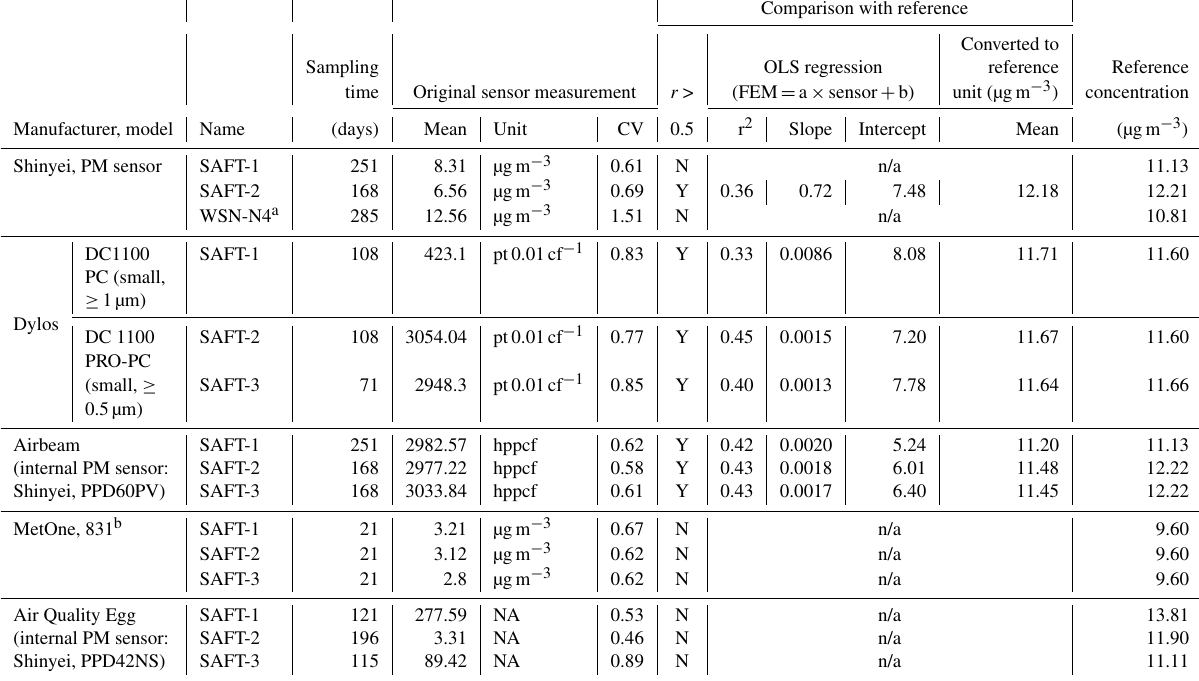
Table 3. Comparison statistics for 12h average PM measurements at South Dekalb NCore